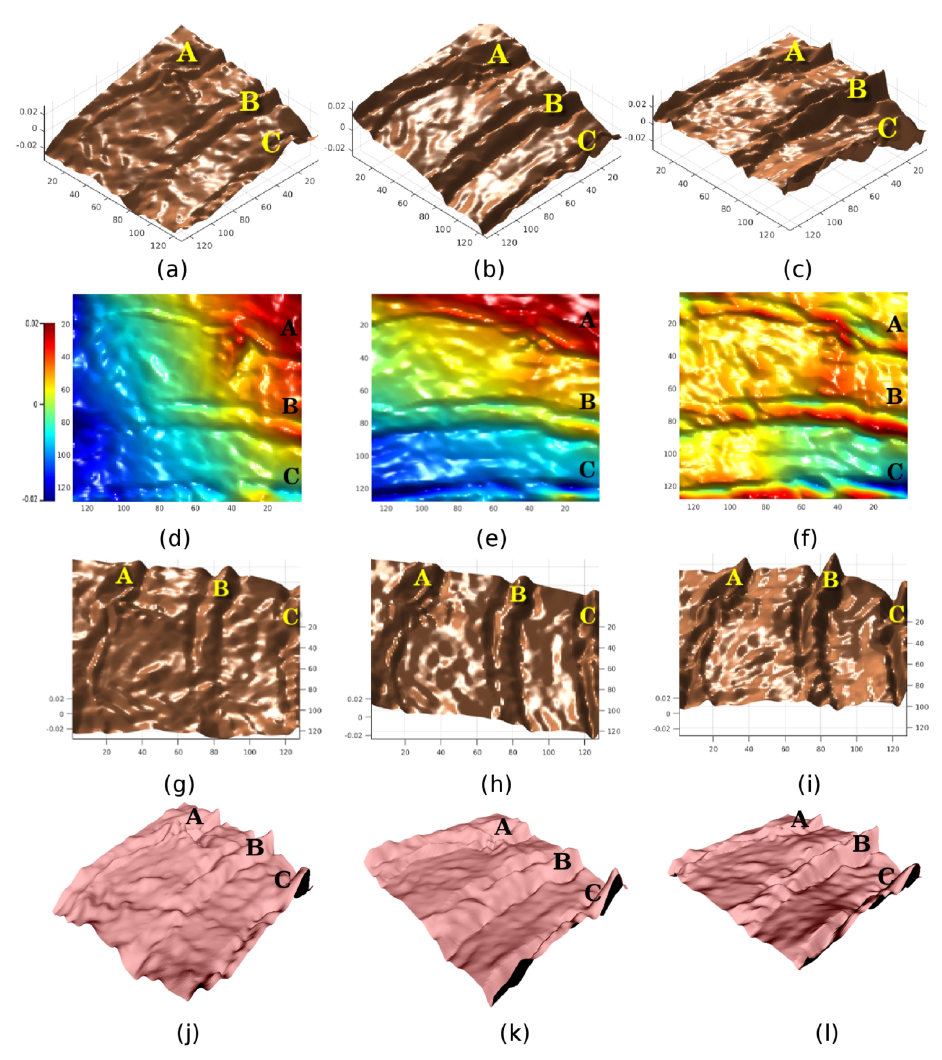
Fig. 14 Depth reconstruction results from real world endoscopy images. First column: using a Lambertian model. Second column: using a Blinn–Phong model with PPS. Third column: using a Blinn–Phong model with PPN. All images are shown using an identical view to visualize differences. Deviations in the Lambertian results can be clearly seen, while the results of our approach provide faithful 3D reconstructions without deviations and also with a high amount of